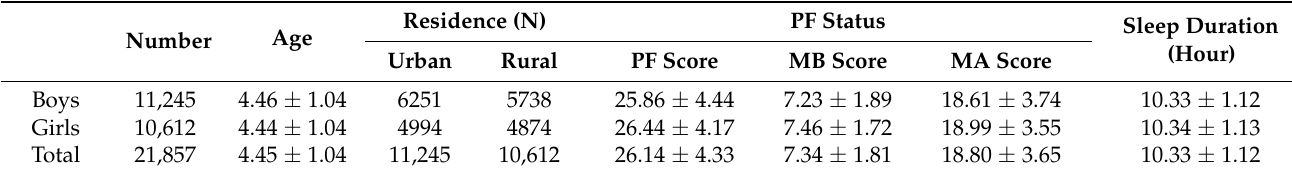
Table 2. Demographic and clinical baseline of the participants.